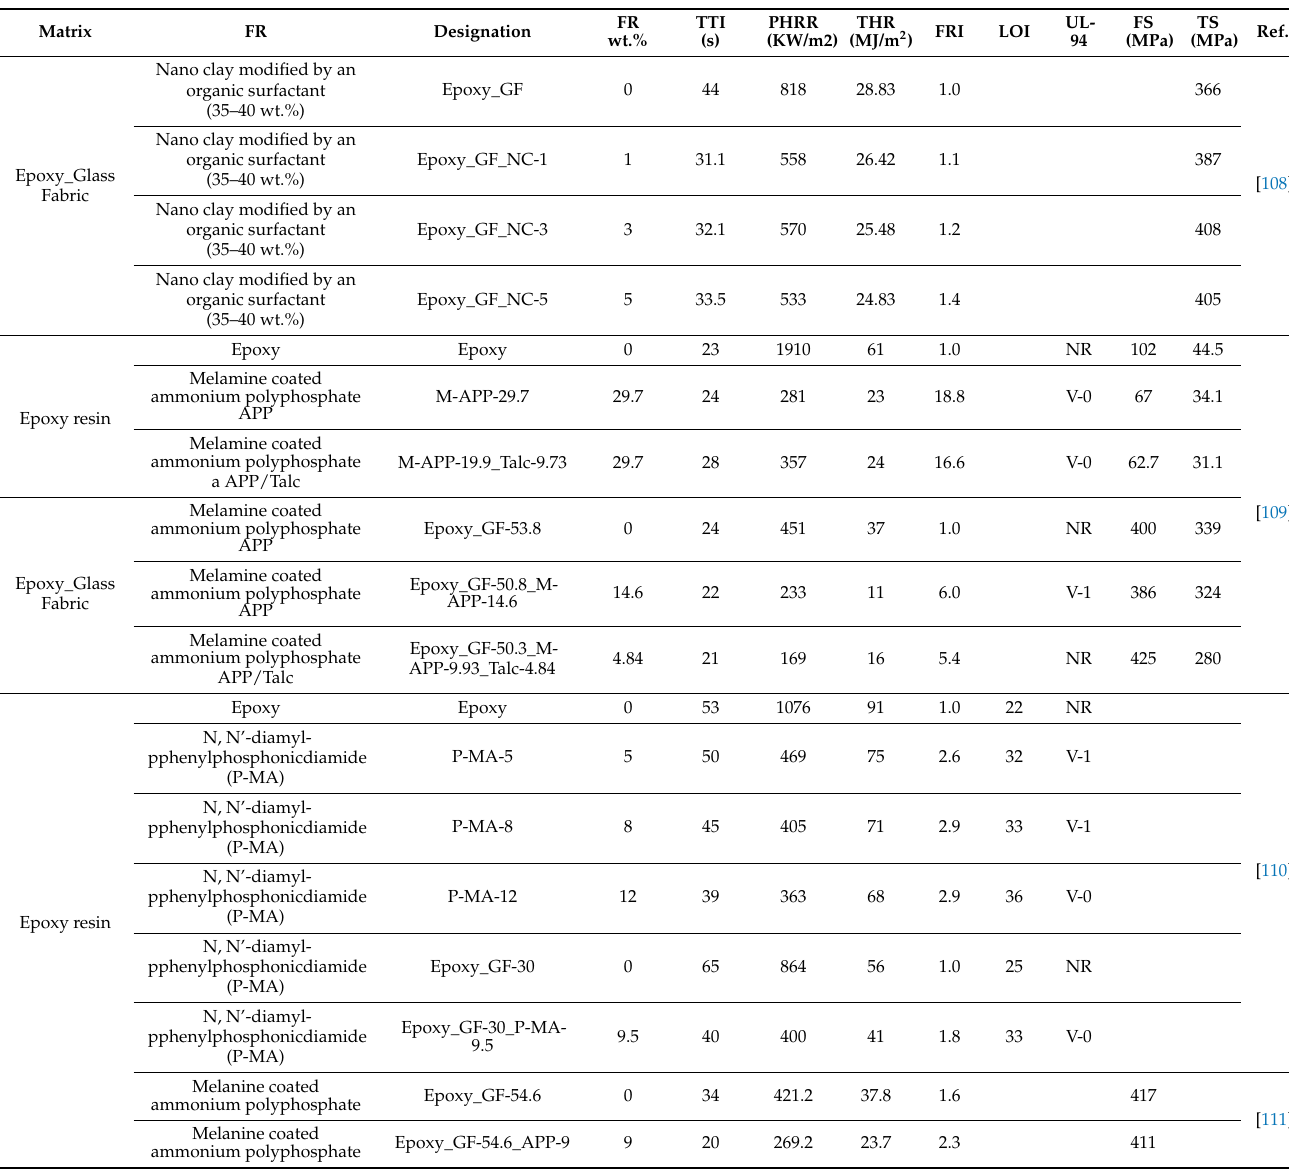
Table 6. Cone colorimetry data (TTI, PHRR, THR), Calculated FRI value, LOI, UL-94, FS and TS for Fabric composites filled with a wide variety of FRs. The designation in the second column refers to the type of matrix followed by fabric type and its wt.% content finally FR type and its wt.% content for example M_F-30_FR 1 -2_FR 2 -5 this means matrix M reinforced with 30 wt.% of Fabric F and incorporated by 2 wt.% of flame retardant type FR 1 and 5 wt.% of flame retardant type FR 2